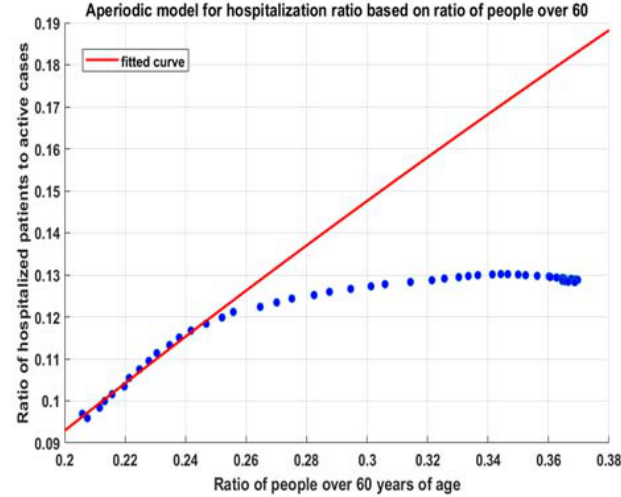
Figure 9. Deviation from the model for hospitalizations from 4 to 21 September 2021.